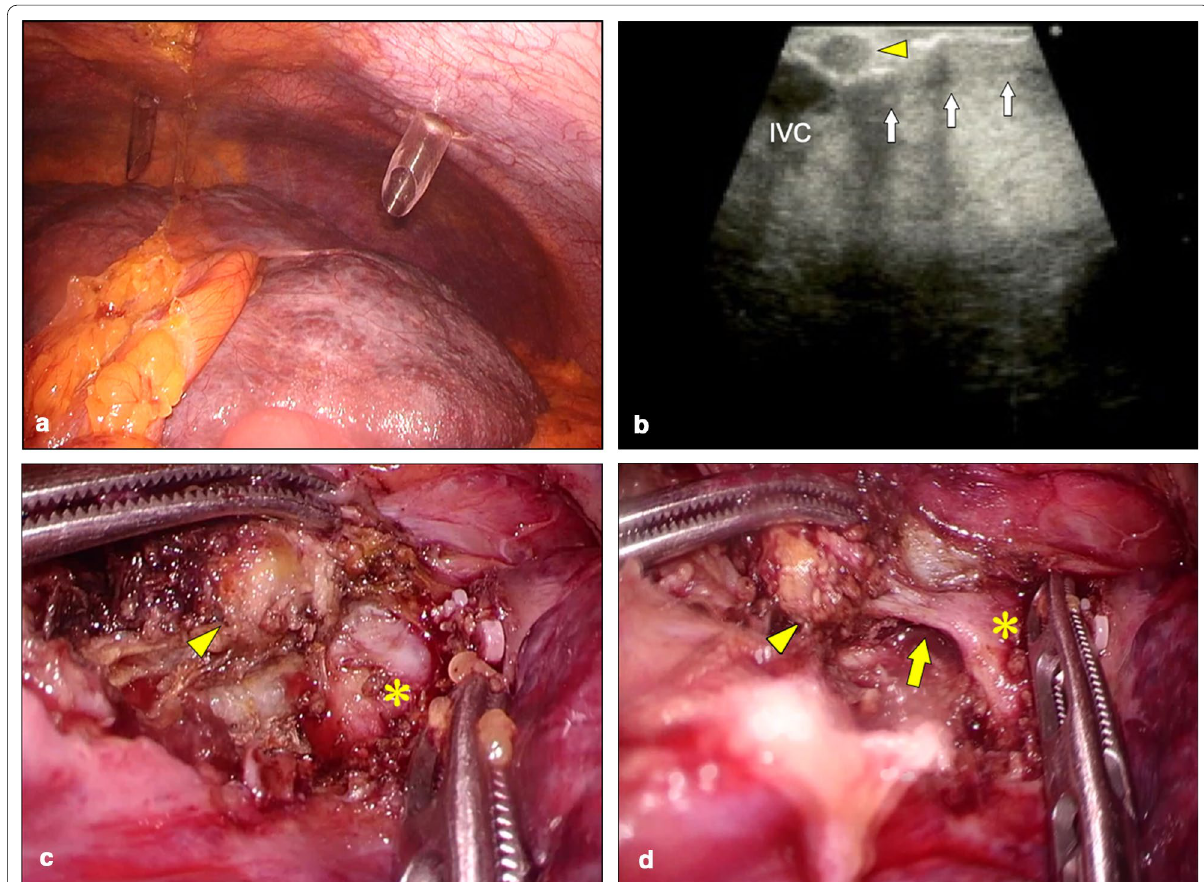
is abutting the left hepatic vein (*). d Tumor (yellow arrowhead) is enucleated with exposure of the left hepatic vein (*). Yellow arrow shows the tributary to the origin of the left hepatic vein from the